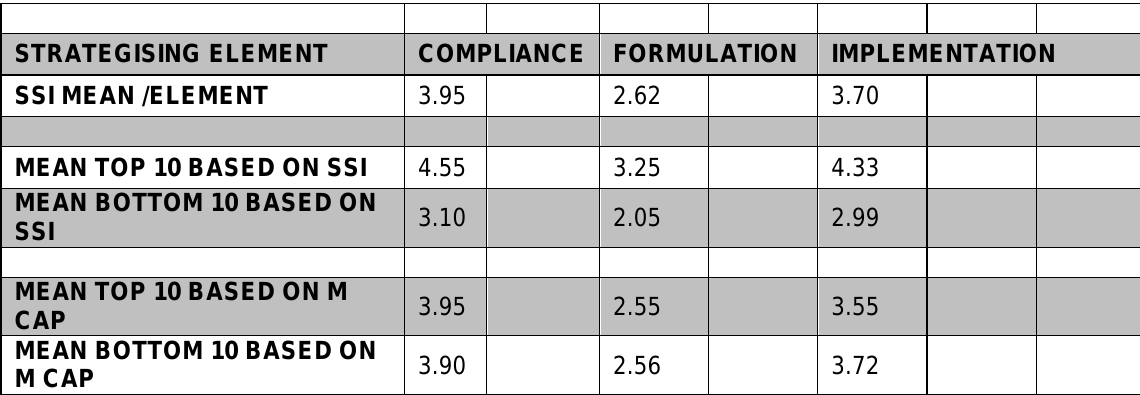
Table 5: Comparison of SSI elements based on different strategising components of formulation and compiled on SSI index and Market